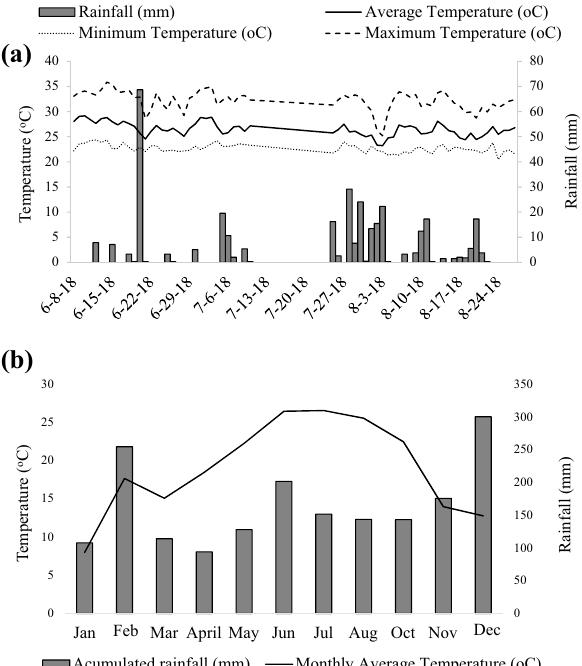
Figure 5. Marianna (FL) station of the Florida Automated Weather Network (FAWN) data of ( a ) weekly rainfall and temperature data from two experimental periods and ( b ) accumulated monthly rainfall (mm) and average temperature (°C). Period 1: from 06/08/2018 to 07/10/2018; Period 2: from 07/25/2018 to